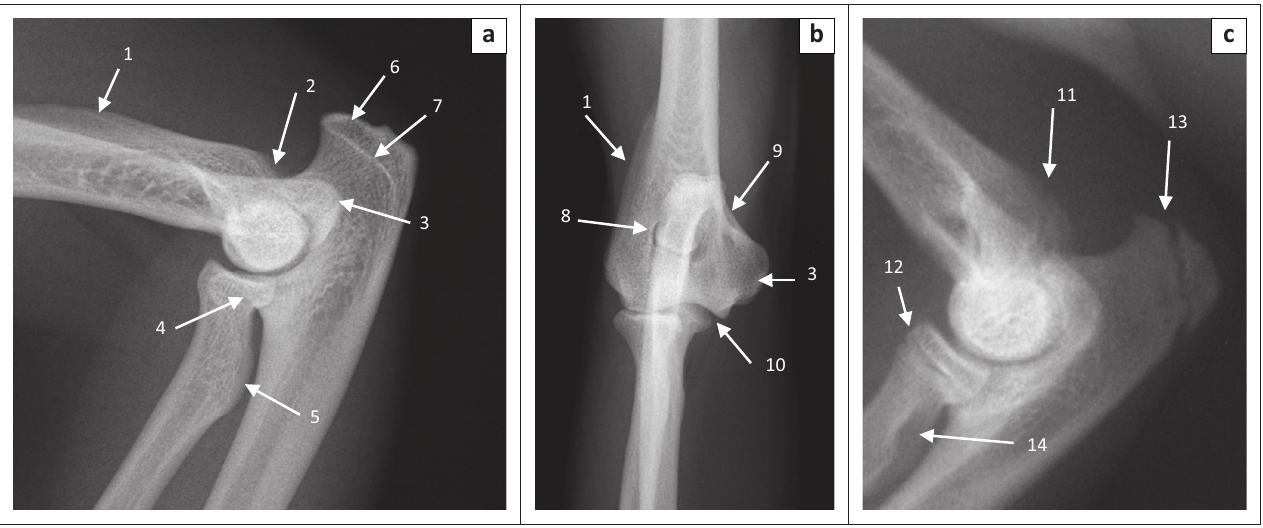
FIGURE 5: Radiographs of the right elbow joint of (a) a 1.4-year-old, (b) a 10.3-year-old and (c) a skeletally immature male red panda. Mediolateral views are shown in (a) and (c) and a craniocaudal view is shown in